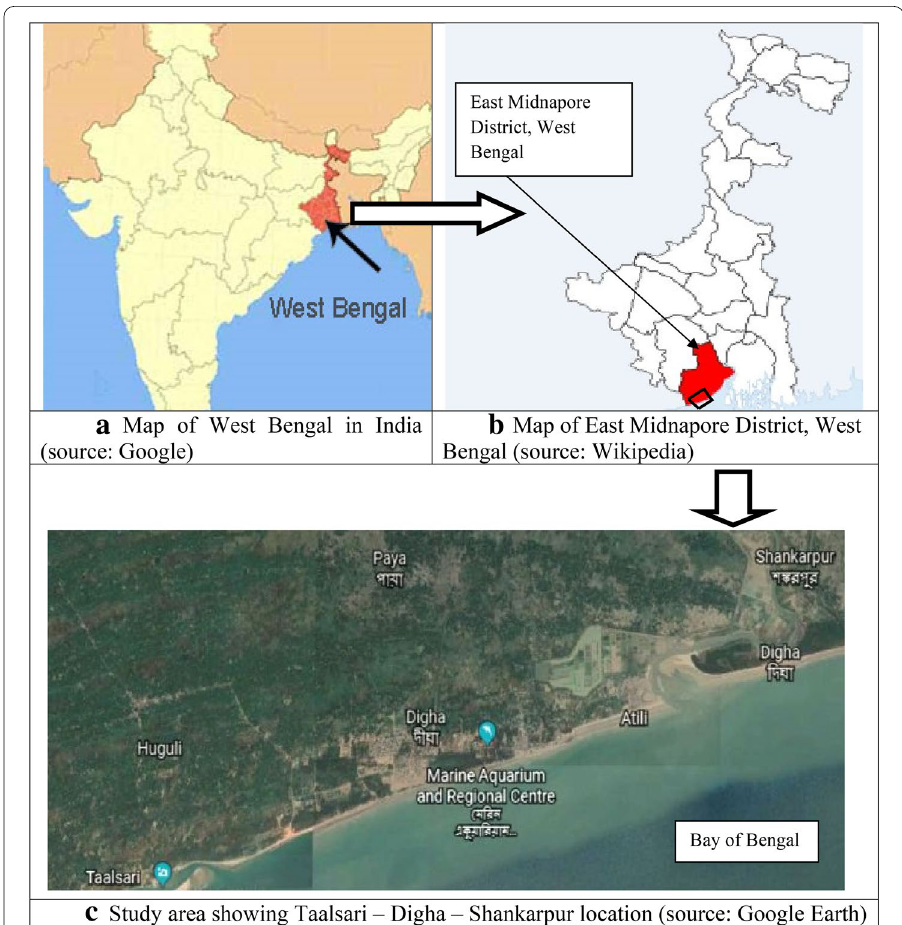
Fig. 1 a Map of West Bengal in India (source: Google). b Map of East Midnapore District, West Bengal (source: Wikipedia). c Study area showing Taalsari–Digha–Shankarpur location (source: Google